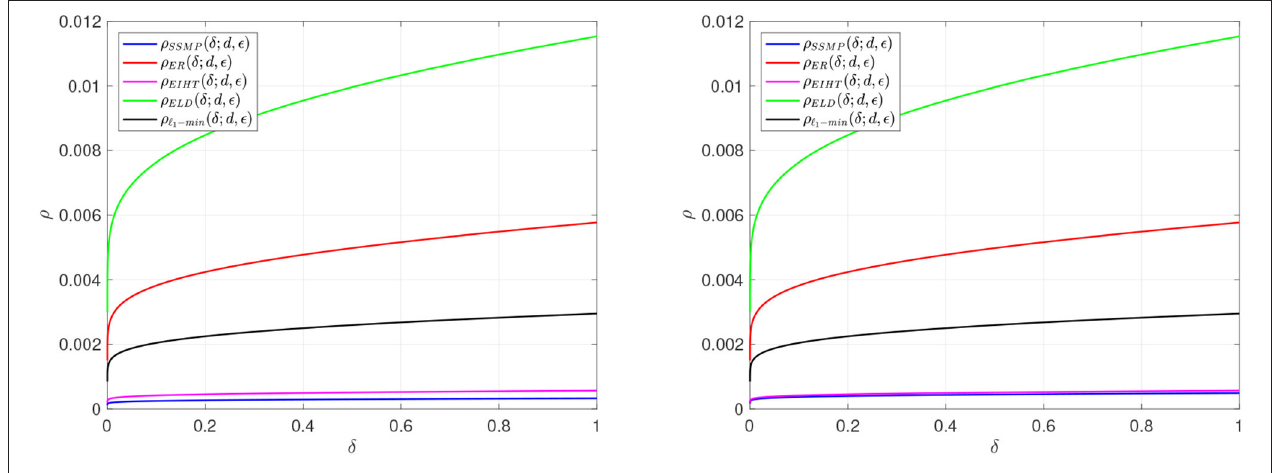
FIGURE 2 | Phase transitions plots of algorithms with fixed d